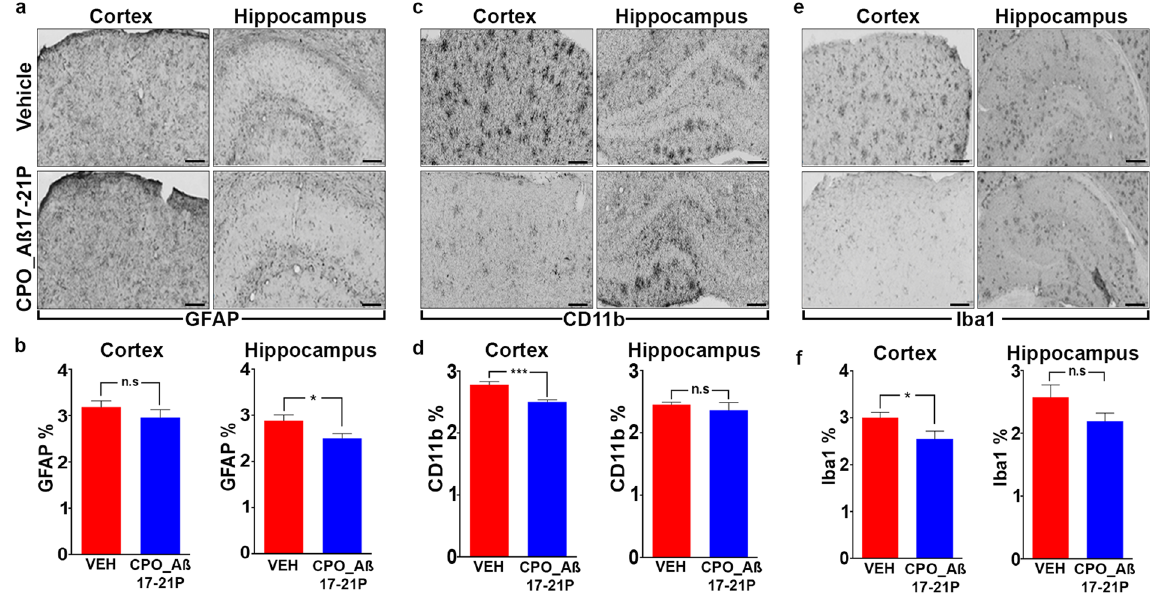
Figure 6. Levels of reactive astrocytes and microglia in brains from APP/PS1 mice treated with CPO_ A β 17-21 P or vehicle. ( a ) Treatment with CPO_ A β 17-21 P had no significant effect on cortical astrogliosis, but it was associated with decreased hippocampal astrogliosis in APP/PS1 mice, ( b ) as quantified by GFAP immunoreactivity. ( c ) Treatment with CPO_ A β 17-21 P decreased cortical, but had no significant effect on hippocampal microgliosis in APP/PS1 mice, ( d ) as quantified by CD11b immunoreactivity, ( e ) CPO_ A β 17- 21 P treatment reduced microgliosis in the cortex, but had no significant effect on hippocampal microgliosis of APP/PS1 mice, ( f ) as quantified by Iba1 immunoreactivity, (Scale bars represent 100 μ m. * p < 0.05, *** p < 0.001, one-tailed unpaired t-